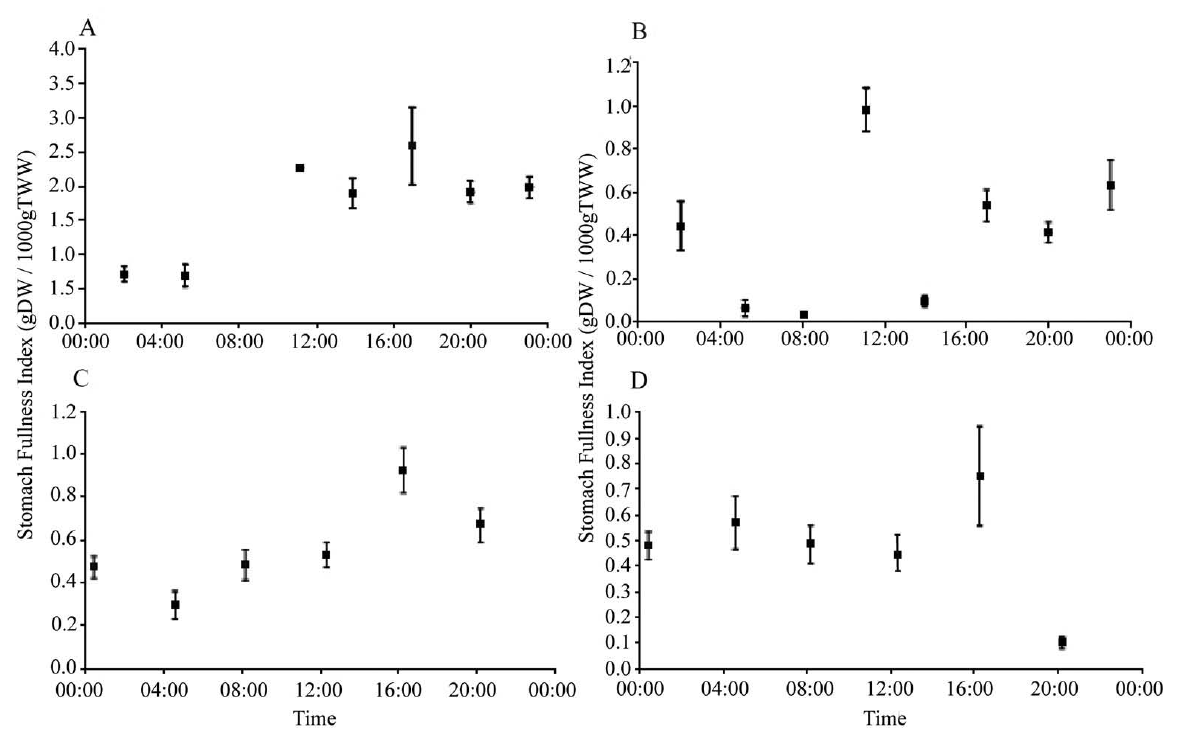
Fig. 4. – Mean stomach fullness index±95% CI plotted over time, as obtained in a sampling carried out in consecutive 24 hours. A, juveniles in summer; B, adults in summer; C, juveniles in winter; D, adults in winter. (Summer sunrise time, 5:04 GMT; summer sunset time, 20:02